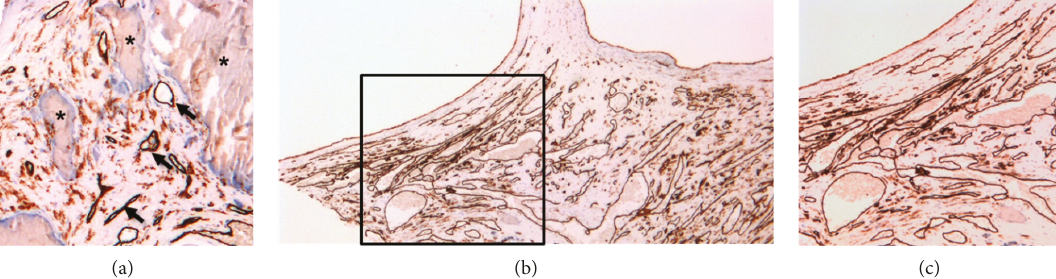
Figure 1: Reactive proliferation of blood vessels. (a) Reactive proliferation of dense blood vessels (arrows) surrounding calci fi ed areas (asterisk) visualised by CD31 staining. Magni fi cation 50x. (b) Overview of aortic valve hemangioma stained for CD31, showing an agglomerate of thin-walled vessels. Magni fi cation 25x. (c) Detailed view of aortic valve hemangioma stained for CD31. Magni fi cation